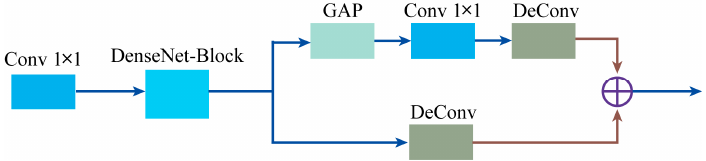
Figure 3. The architecture of the global attention unit.